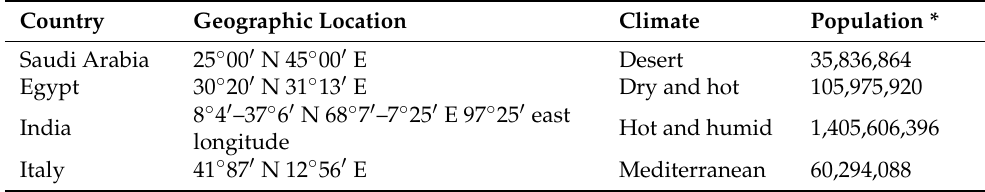
Table 2. Information about the case studies considered.